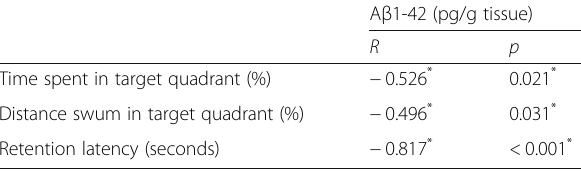
Correlations between two quantitative variables were assessed using Pearson ’ s coefficient *Statistically significant at p ≤